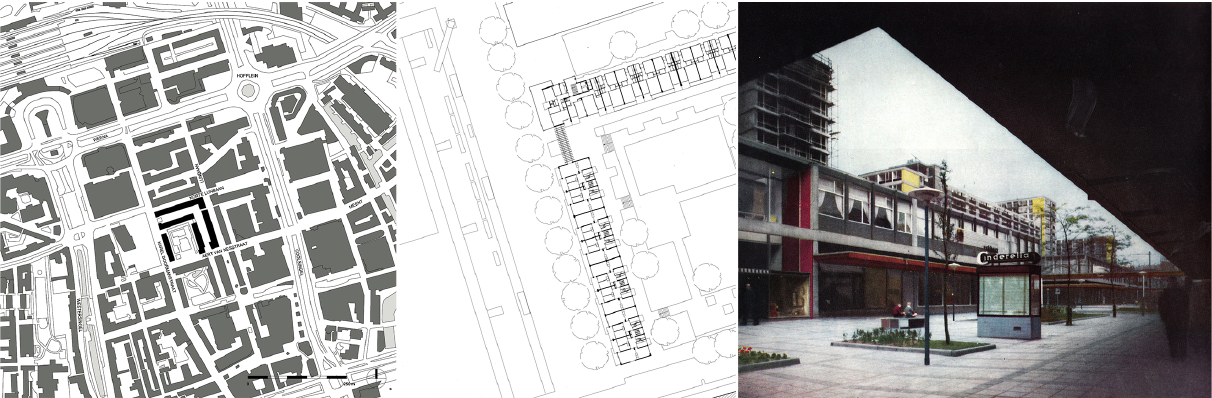
Figure 4. The model of the Lijnbaan. From left to right: Floor plan 1:5000; fragment first-floor plan 1:500; the Lijnbaan ensemble as a three-dimensional composition of high-rise slabs, medium-height, and low-rise volumes, which forms the shopping street designed as a public interior. Notes: The sketch shows the coherent measurement system in the shop- ping area; the colour scheme of yellow, red, and blue refers to the De Stijl movement and stresses unity and identity. Source: